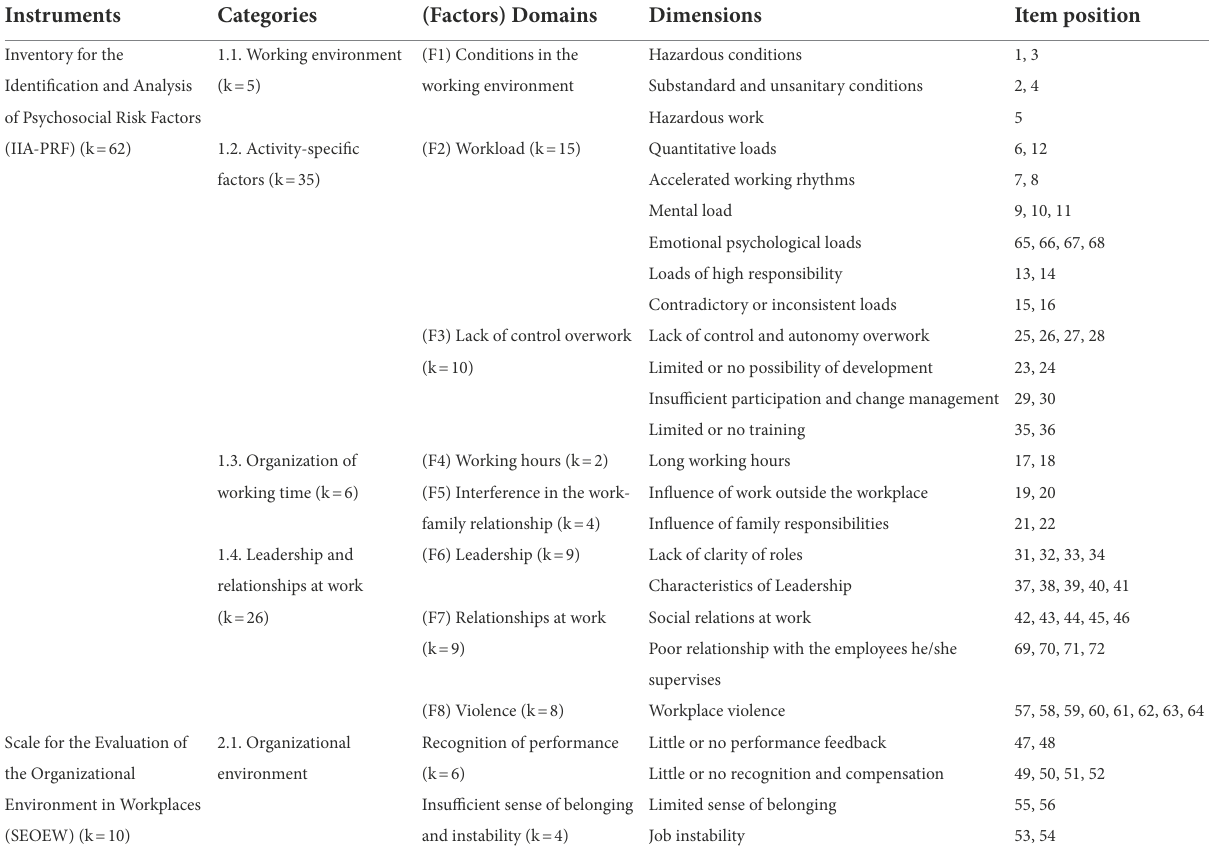
TABLE 1 Structure of the two instruments of the Reference Guide III recommended by NOM-035-STPS-2018 for the evaluation of the organizational climate in workplaces with a population of more than 50 workers.